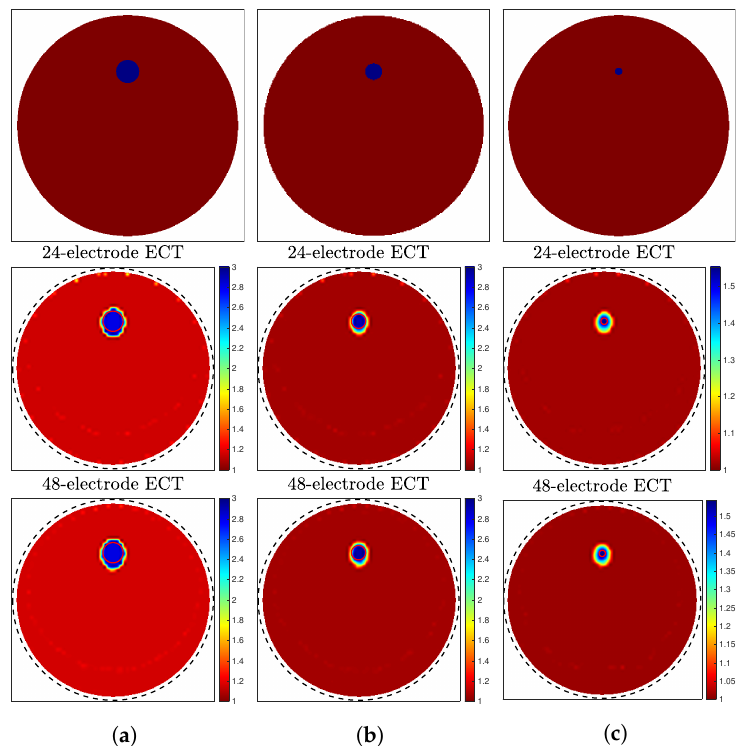
Figure 4. Illustration of ECT image reconstruction of small objects. The top images show the true distribution. The middle and bottom images show reconstructed images obtained using ILM with 24-electrode and 48-electrode ECT systems. The respective areas of the object of interest in the figures are ( a ) 1%, ( b ) 0.5%, and ( c ) 0.1% of the RoI,